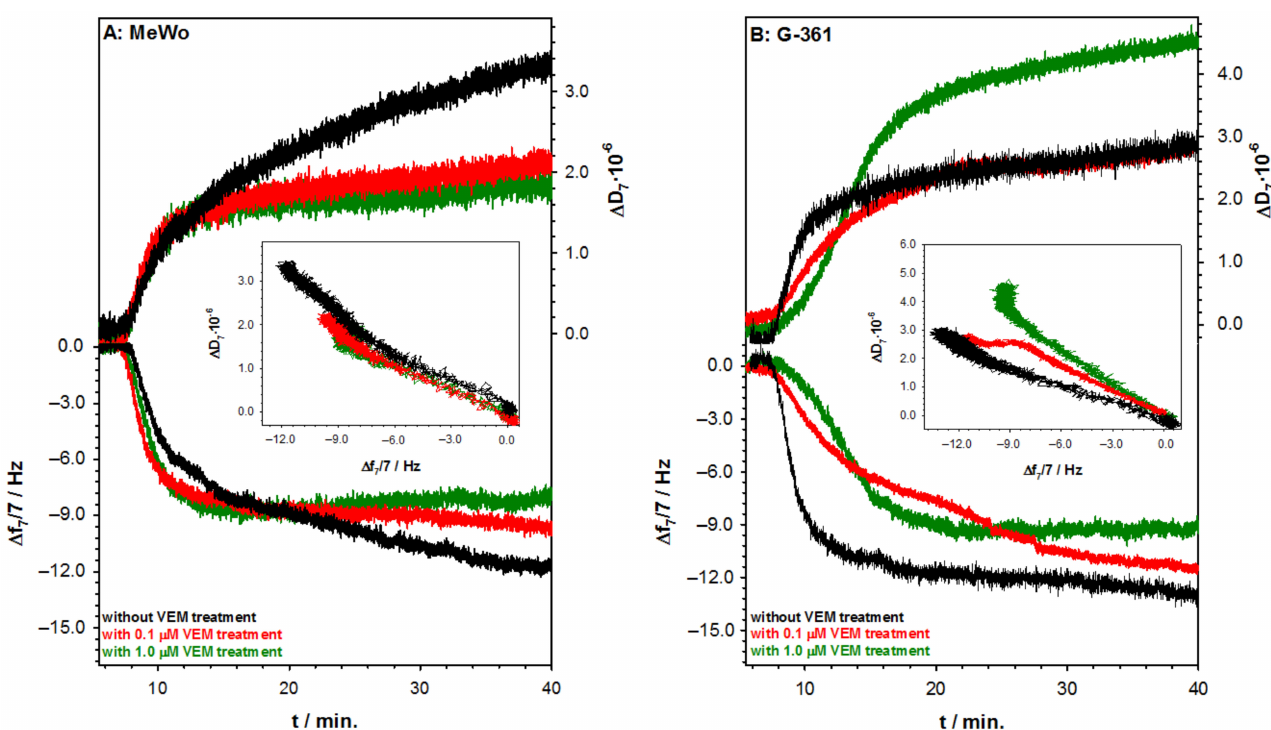
Figure 5. ( A ) QCM-D spectra of the shifts in frequency ( ∆ f ) and dissipation factor ( ∆ D ) recorded during the binding of Con A to glycans of melanoma cell lines with wild type (MeWo); ( B ) and with BRAF mutation (G-361) treated or untreated with VEM. Insets: ∆ D versus ∆ f plots of Con A binding to glycans of melanoma cell lines. Experimental conditions: PBST buffer; C Con A = 50 µ g · mL − 1